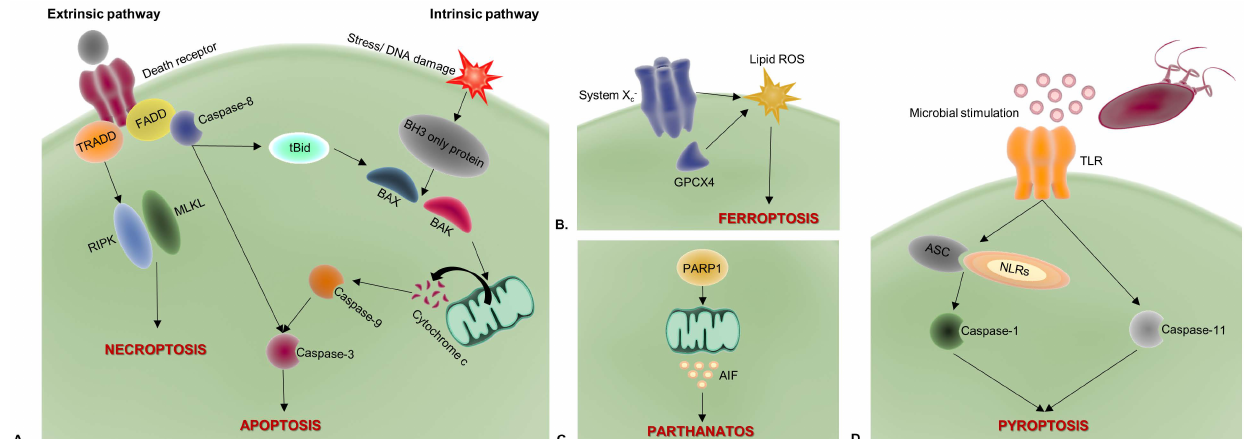
Figure 2. An overview of ICD mechanisms and key regulatory molecules. The main ICD modalities shown are apoptosis and necroptosis ( A ), ferroptosis ( B ), parthanatos ( C ), and pyroptosis ( D ). Arrows indicate the pathway flow and the relative regulatory molecules. AIF, apoptosis-inducing factor; ASC, apoptosis-associated speck-like protein containing a CARD; BAK, Bcl-2 homologous antagonist killer; BAX, Bcl-2-like protein 4; FADD, FAS-associated death domain protein; GPX4, glutathione peroxidase 4; MLKL, mixed lineage kinase domain-like pseudokinase; NLRs, NOD-like receptors; PARP1, poly(ADP-ribose) polymerase-1; RIPK, receptor-interacting protein kinase; ROS, reactive oxygen species; TLR, Toll-like receptor; and TRADD, tumor necrosis factor receptor type 1-associated death domain